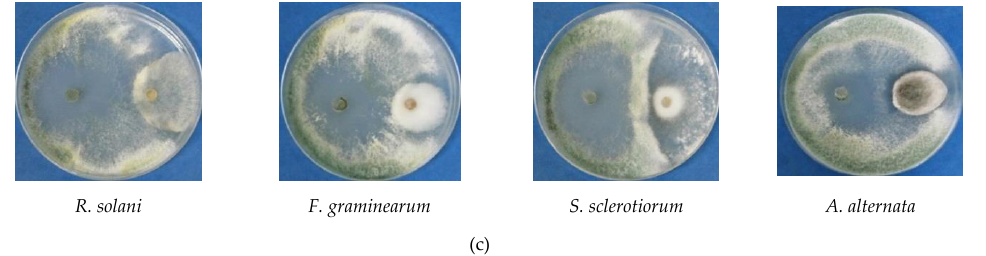
Figure 1. Antagonism by Trichoderma isolates against fungal phytopathogens. Dual culture of Trichoderma spp. and pathogens. ( a ) pathogen pure cultures — control. ( b ) T. asperellum versus pathogens (black arrow-sporulation). ( c ) T. atroviridae versus pathogens. Table 1. Inhibition of pathogen growth in presence of antagonists.